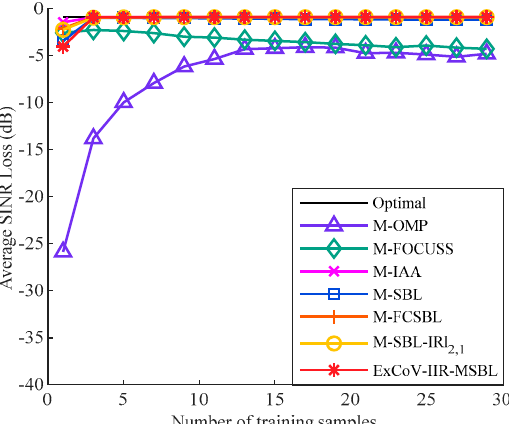
Figure 6. The average SINR loss versus the number of training samples in the ideal case.